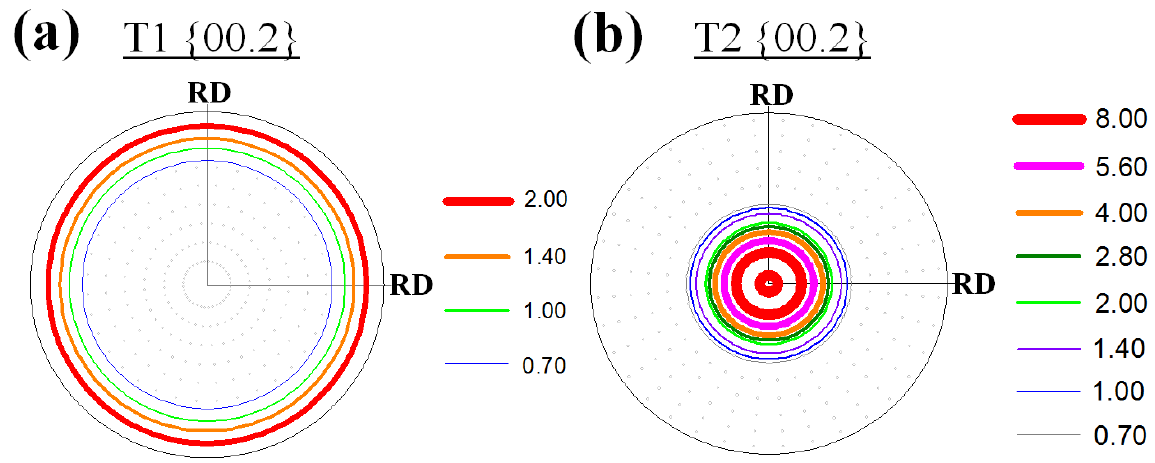
Figure 1. Initial textures of ( a ) T1 and ( b ) T2 samples determined by neutron